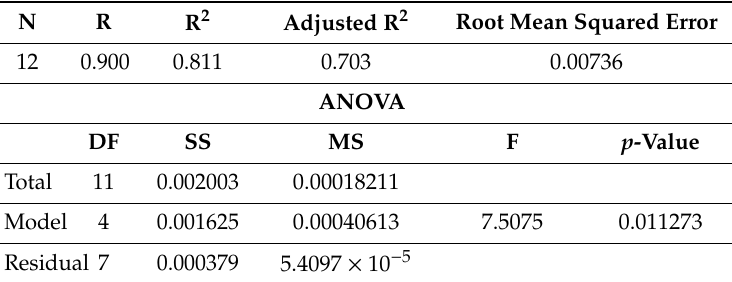
Table 6. Cylindricity Model Summary.